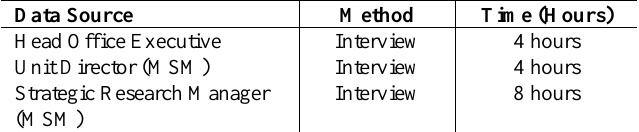
Table 1: Interview schedule